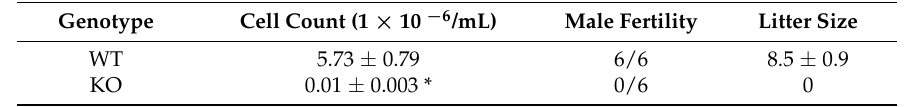
Table 1. Sperm count and fertility.